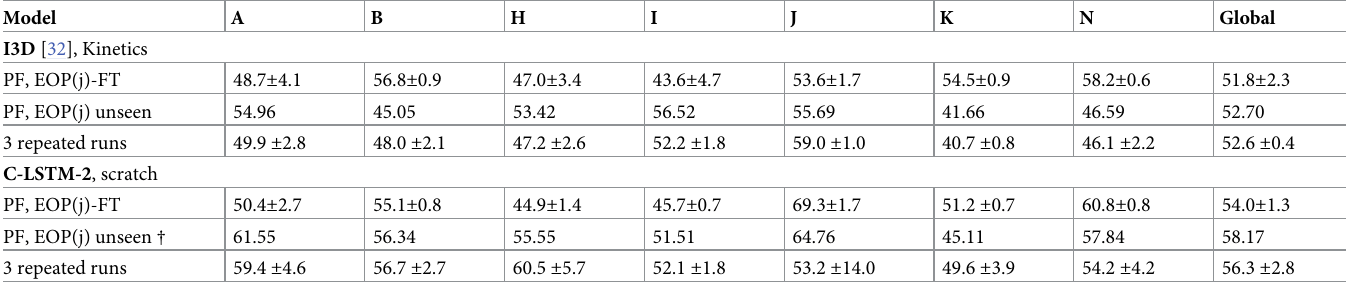
Table 5. F1-scores on EOP(j), when varying the source of domain transfer, for models trained according to Section 3.3. FT means fine-tuned (three repetitions of full cross-validation runs). Column letters indicate different test subjects. † represents a specific model instance, reoccurring in Tables 2, 6 and 7. Model